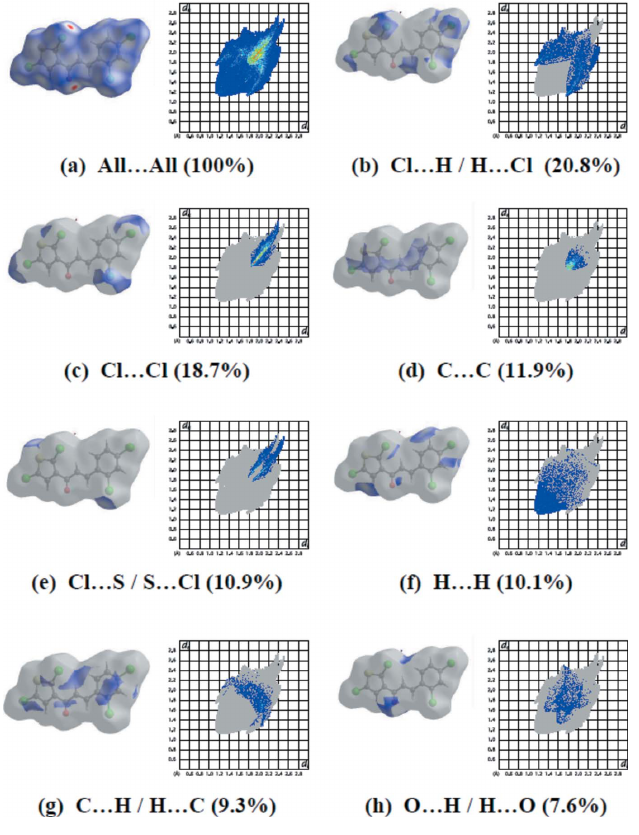
Figure 3 The two-dimensional fingerprint plots of the title compound, showing ( a ) all interactions, and delineated into ( b ) Cl (cid:3)(cid:3)(cid:3) H/ H (cid:3)(cid:3)(cid:3) Cl, ( c ) Cl (cid:3)(cid:3)(cid:3) Cl, ( d ) C (cid:3)(cid:3)(cid:3) C, ( e ) Cl (cid:3)(cid:3)(cid:3) S/S (cid:3)(cid:3)(cid:3) Cl, ( f ) H (cid:3)(cid:3)(cid:3) H, ( g ) C (cid:3)(cid:3)(cid:3) H/H (cid:3)(cid:3)(cid:3) C and ( h ) O (cid:3)(cid:3)(cid:3) H/ H (cid:3)(cid:3)(cid:3) O